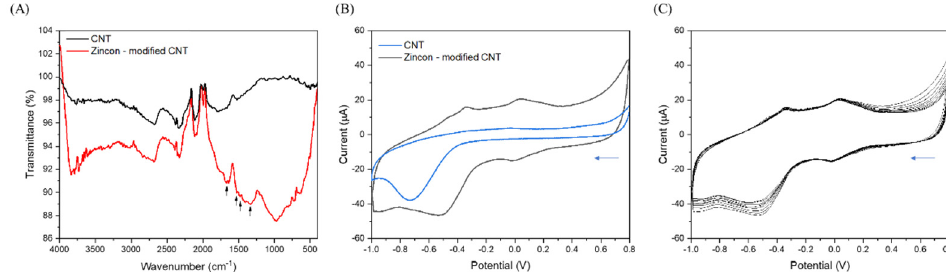
Figure 2. ( A ) FTIR spectrum of CNT and zincon–modified CNT, where black arrows show the zincon peaks. ( B ) CV showing the reduction and oxidation peaks of zincon present on CNT after grafting process. The zincon–modified CNT showed good stability after ( C ) 10 CVs on tris–HCl (pH 7.5), scan rate 10 mV/s. The blue arrows mean the direction of the CV from + to − .